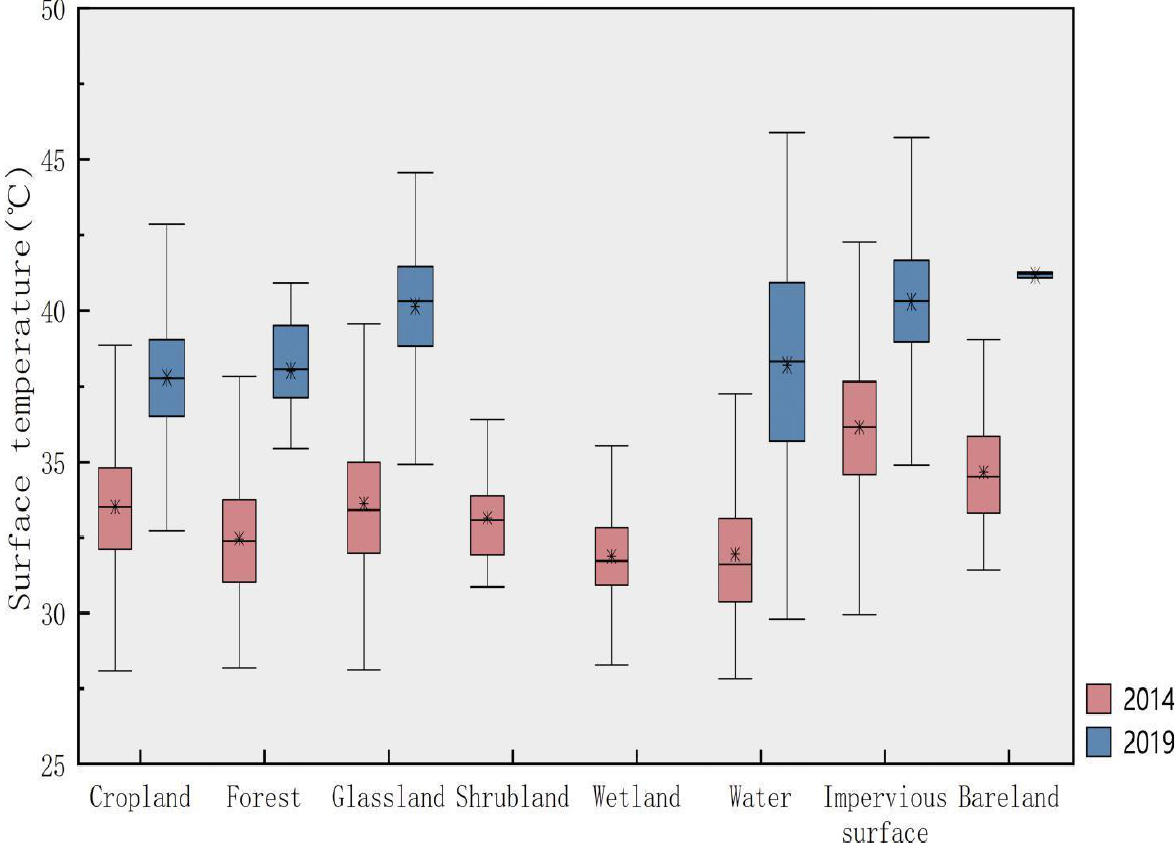
Figure 3. LST in different land cover areas